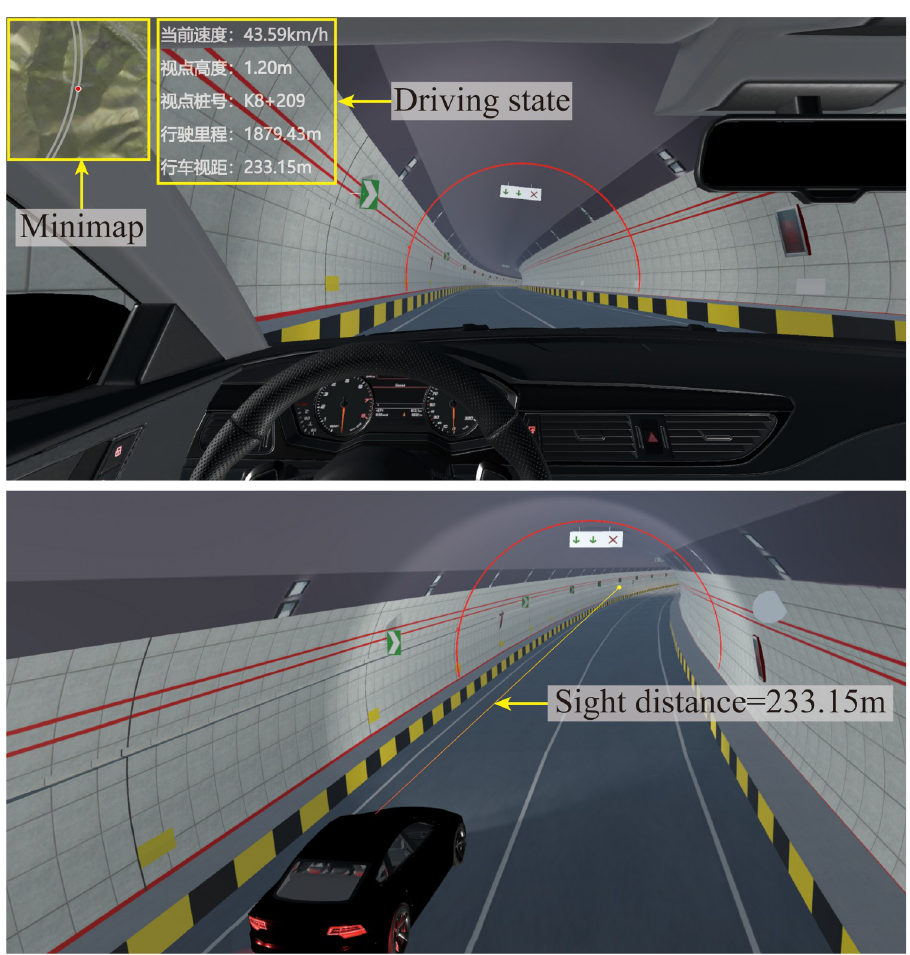
Fig 11. Driving state perception and sight distance